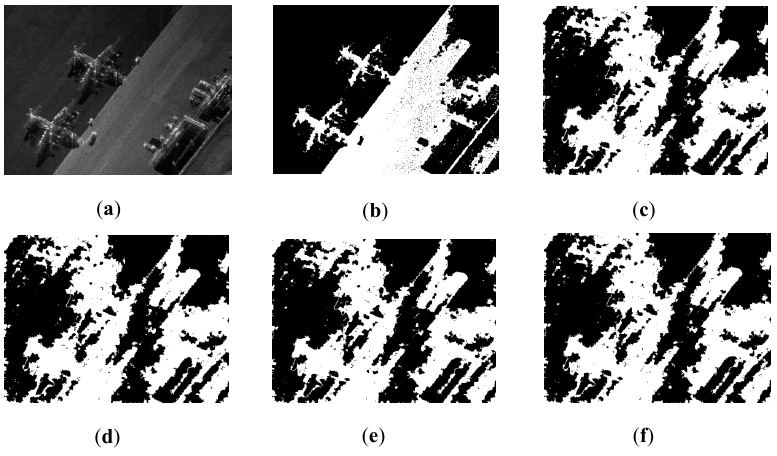
Figure 15. Segmentation results on SAR6. ( a ) original image; ( b ) AFWDLMO; ( c ) AFCMOMA;